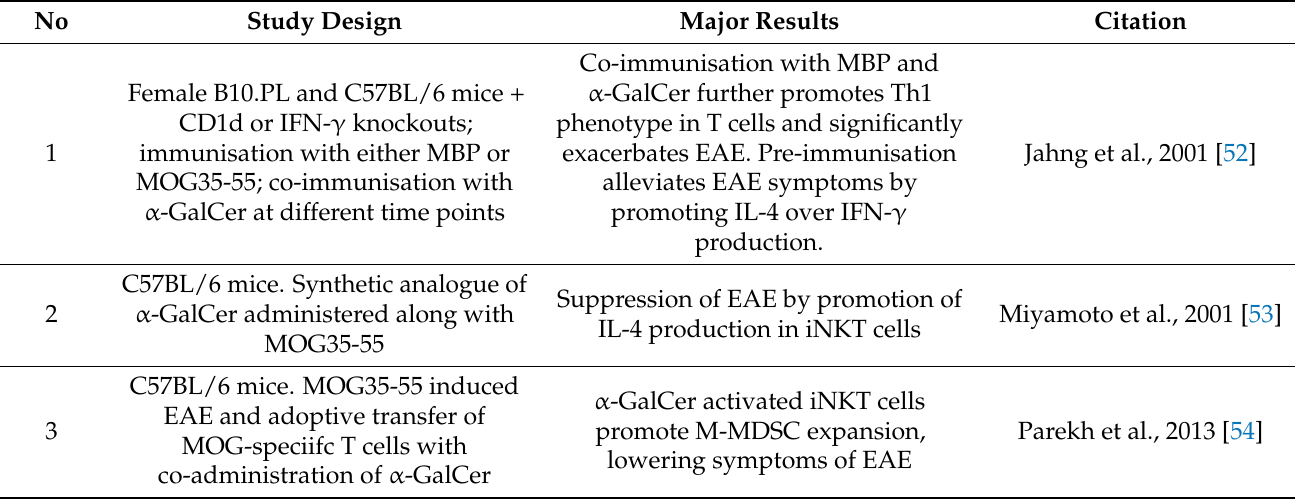
Table 1. Involvement of iNKT in EAE—major